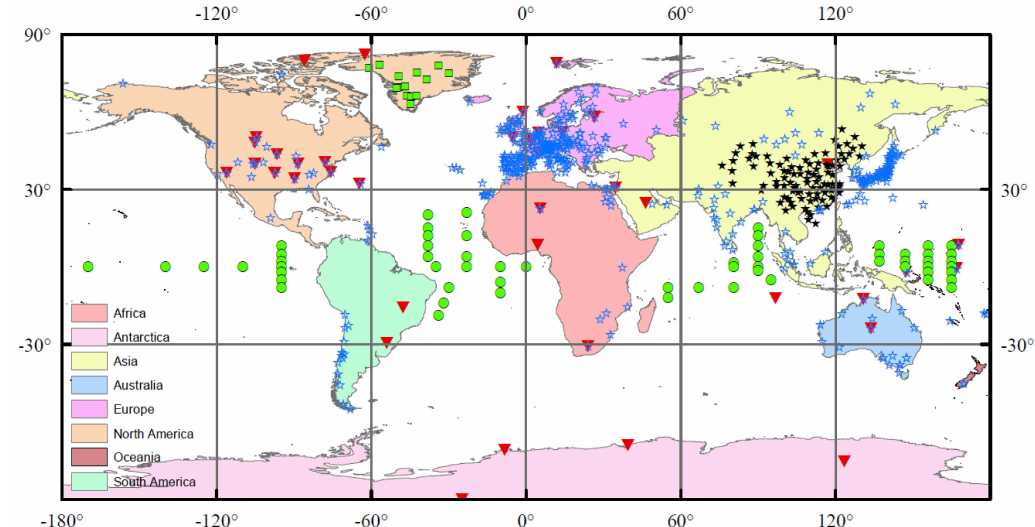
Figure 1. Geographical distribution of observation sites (674 sites in total) used in this study from GEBA (458 sites in blue asterisks), from BSRN (44 sites in red triangles), from Buoy observations (60 sites in green circles), from GC-NET (16 sites in green squares), and from CMA (96 sites in black